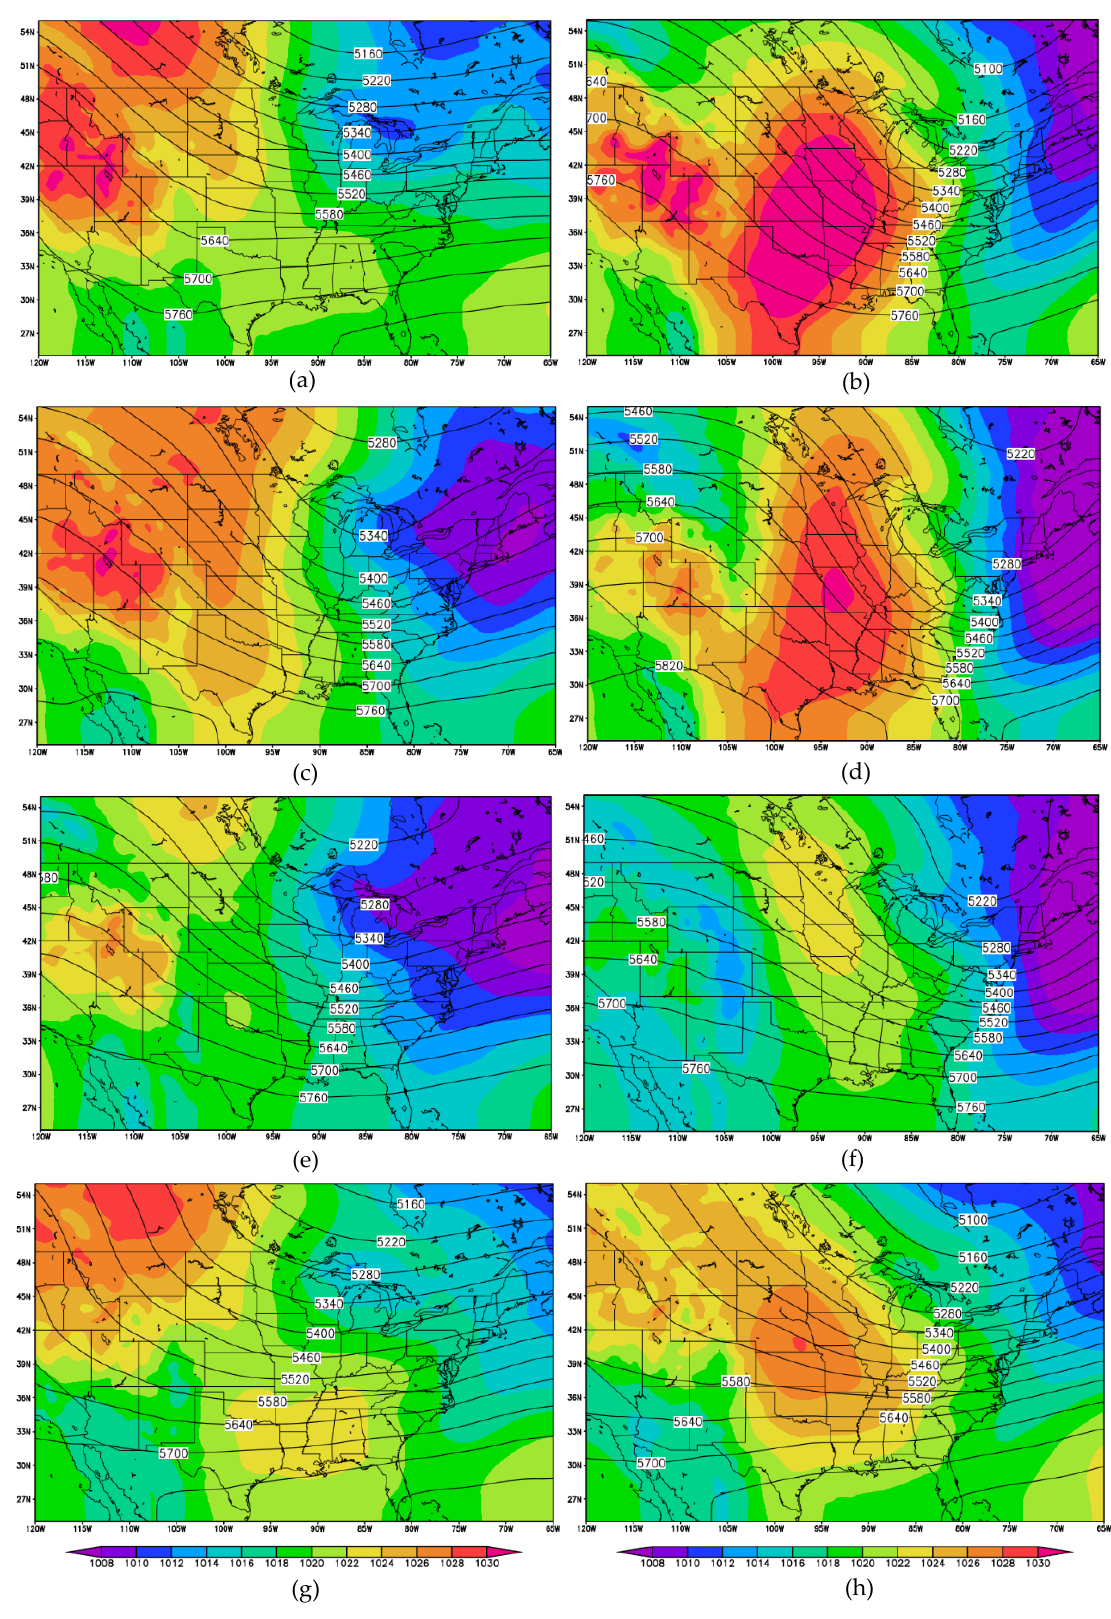
Figure 7. Lake Michigan 500 mb geopotential height (contours; m) and mean sea-level pressure (MSLP) (shaded; mb) composites at t = 0 h for Cluster 1 ( a ), Cluster 2 ( c ), Cluster 3 ( e ), and Cluster 4 ( g ) and t = 42 h for Cluster 1 ( b ), Cluster 2 ( d ), Cluster 3 ( f ), and Cluster 4 ( h